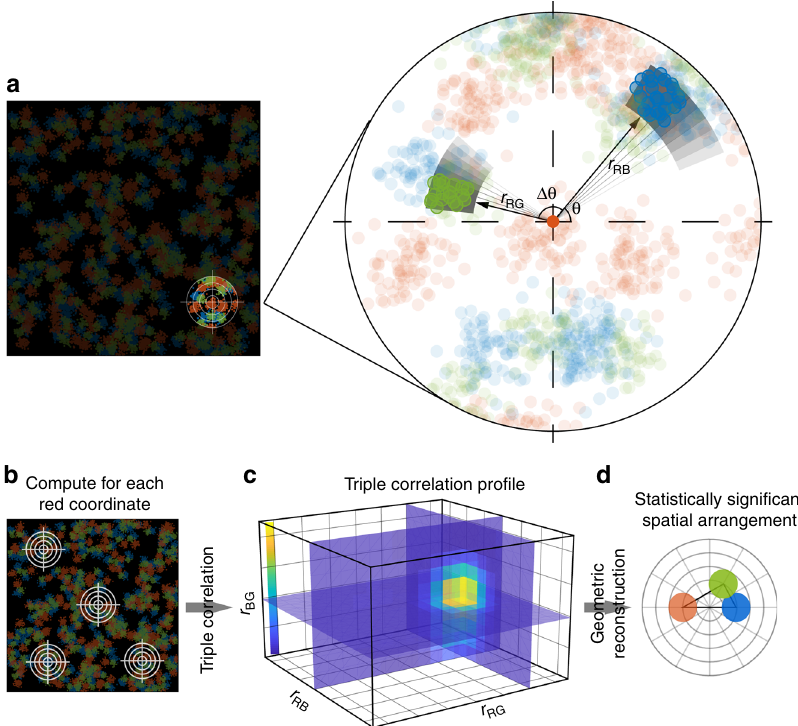
Fig. 1 Schematic illustration of the direct TC algorithm. a Schematic illustration of dTC computation. Considering three sets of coordinates from blue, red, and green channel, the triple-correlation is calculated as: Each coordinate r CH R i in the red channel is visited as origin O (zoom-in, highlighted red). The density of blue coordinates positioning at r RB = ( r RB , θ ) (highlighted blue) within the differential area ( Δ S = r RB d θ d r ) and that of the green coordinates positioning at r RG = ( r RG , θ + Δ θ ) (highlighted green) within the differential area ( Δ S = r RG d θ d r ) are calculated and multiplied. The product is then integrated along θ through [0, 2 π ] or appropriate range [ φ 1 , φ 2 ] for edge correction (Supplementary Figure 1). b The same calculation in a is iteratively performed and integrated as each red coordinate is visited as an origin, followed by normalizing with the size of the canvas and the average molecular density of the three molecular species. c The computed triple-correlation pro fi le is then plotted as a function of the triple-wise distances { r RB , r RG , r BG }. d The local maximum(s) signi fi cantly higher ( ≥ mean + 2.5 SD) than the fl uctuation of the triple-correlation pro fi le ( c ) is found at certain r max and drawn as a triangle that represents probable geometric con fi guration among these three species. The size of the circles at the vertexes represent